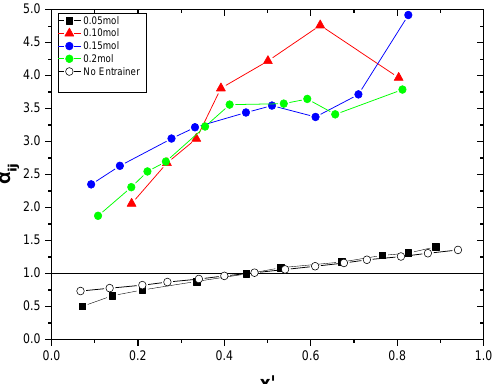
Figure 9. Experimental X’Y diagram for the pseudo-ternary systems (cyclohexane (1) + benzene (2) + DES(1:2)(3)) at atmospheric pressure and constant DES molar fraction ( X 3 = 0.1), and the experimental XY diagram for binary system (cyclohexane (1) + benzene (2)).